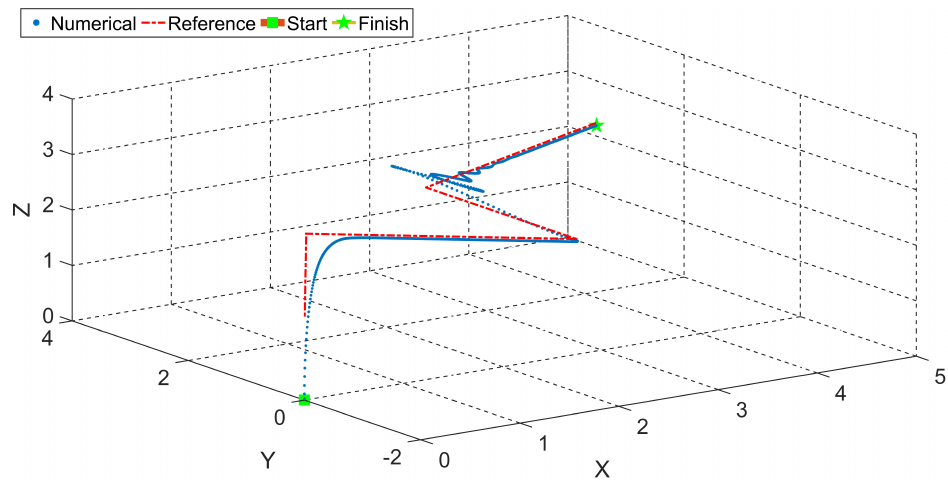
Figure 10. Reference and recorded flight paths (Exp. no. 2).